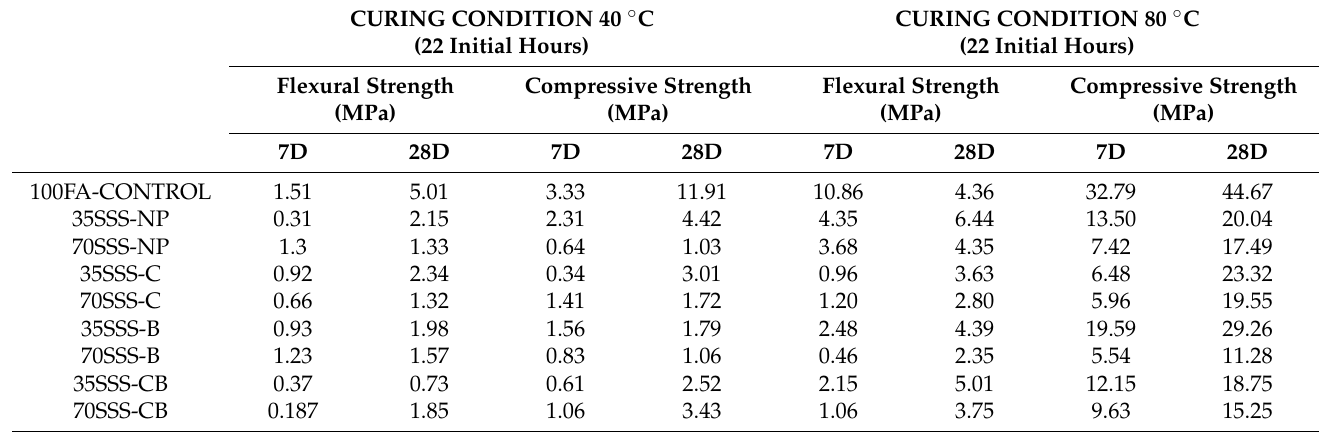
Table 6. Flexural and compressive strength of alkali-activated slag